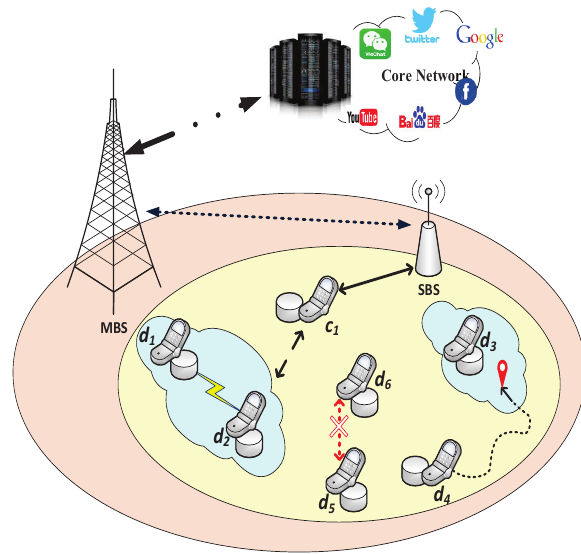
Figure 1. An illustration of cache-enabled D2D